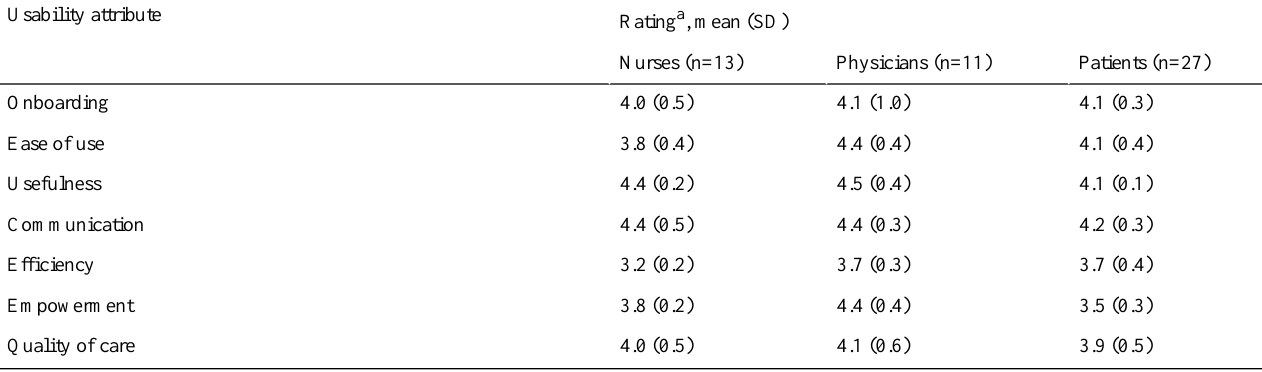
Table 1. Digital patient monitoring and management tool user satisfaction among interim survey